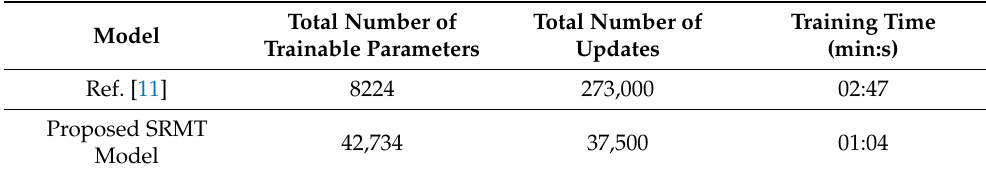
Table 10. A comparison of the total number of trainable parameters, total number of updates, and training time between the existing SRMT model [11], the proposed SRMT model.